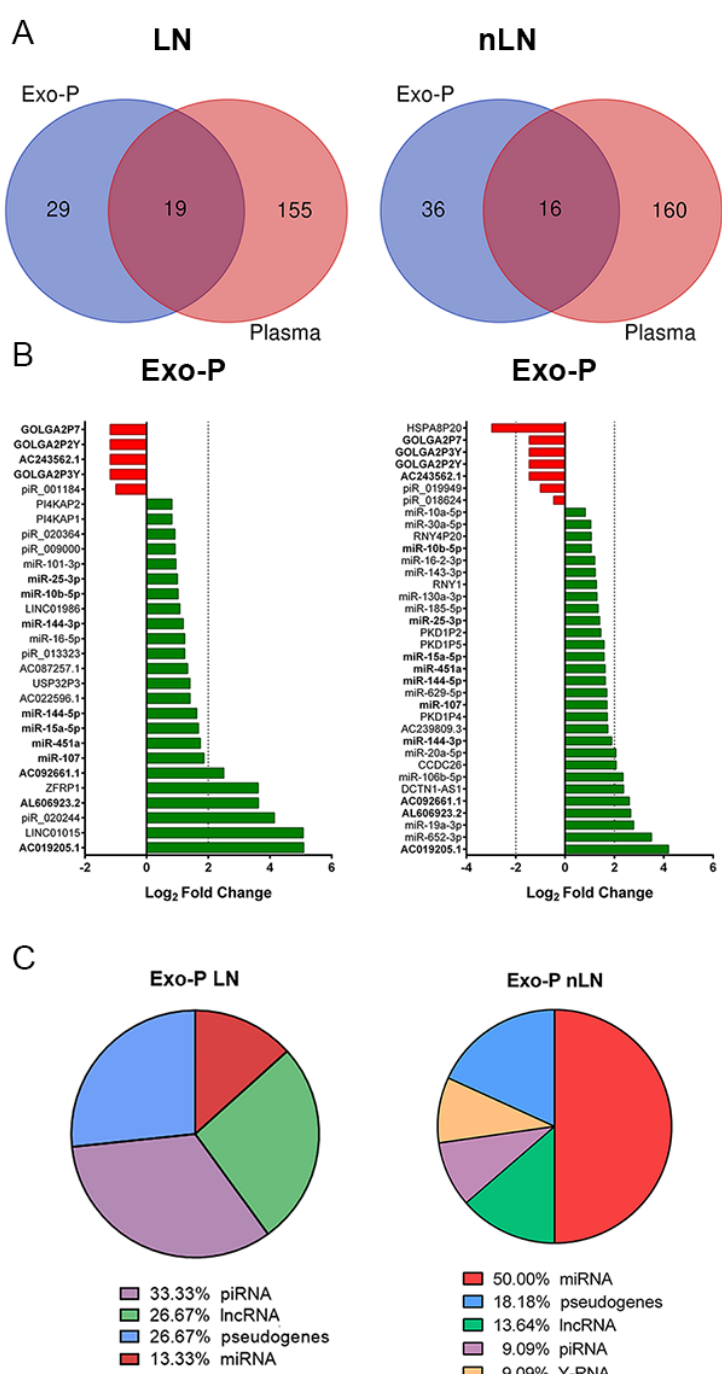
Figure 2. Differentially expressed ncRNAs profiles in plasma exosome fraction of SLE patients with or without LN compared to control subjects. ( A ) Venn diagram shows the overlap among biological fractions. ( B ) Diverging bar charts show the fold-change expression of the exosomal non-coding RNAs signature in both groups: upregulated are in green and downregulated in red. Common NcRNAs in both signatures are in bold. logFC: logarithm 2 base fold-change; ( C ) Proportions of DE ncRNA biotypes in plasma exosomes from SLE patients with LN or without (nLN). Exo-P: plasma exosomes; LN, lupus nephritis; lncRNA: long non-coding RNA; miRNA: microRNA; piRNA: PIWI-interacting RNA; nLN: non lupus nephritis.